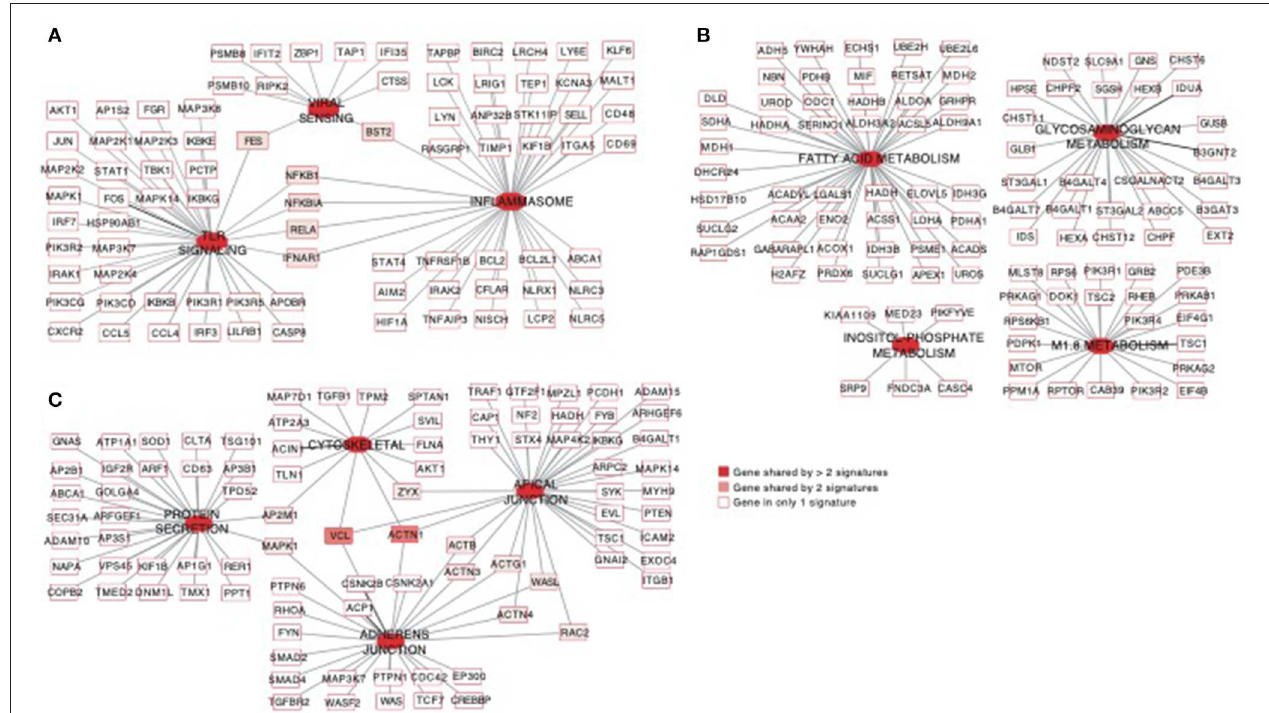
FIGURE 5 | Pathways of viral sensing and TLR signaling, metabolism, cell motility and protein export are enriched in the NK RMtsig. (A–C) Gene networks representing pathways of viral sensing, TLR signaling, inflammasome (A) , metabolism pathways (B) and cell motility and protein export pathways (C) enriched in the NK RMtsig. Genes shared by 2 or more pathways were highlighted with full red boxes, where red color gradient represents the number of pathways that share this gene. Unique genes for each pathway were shown in empty